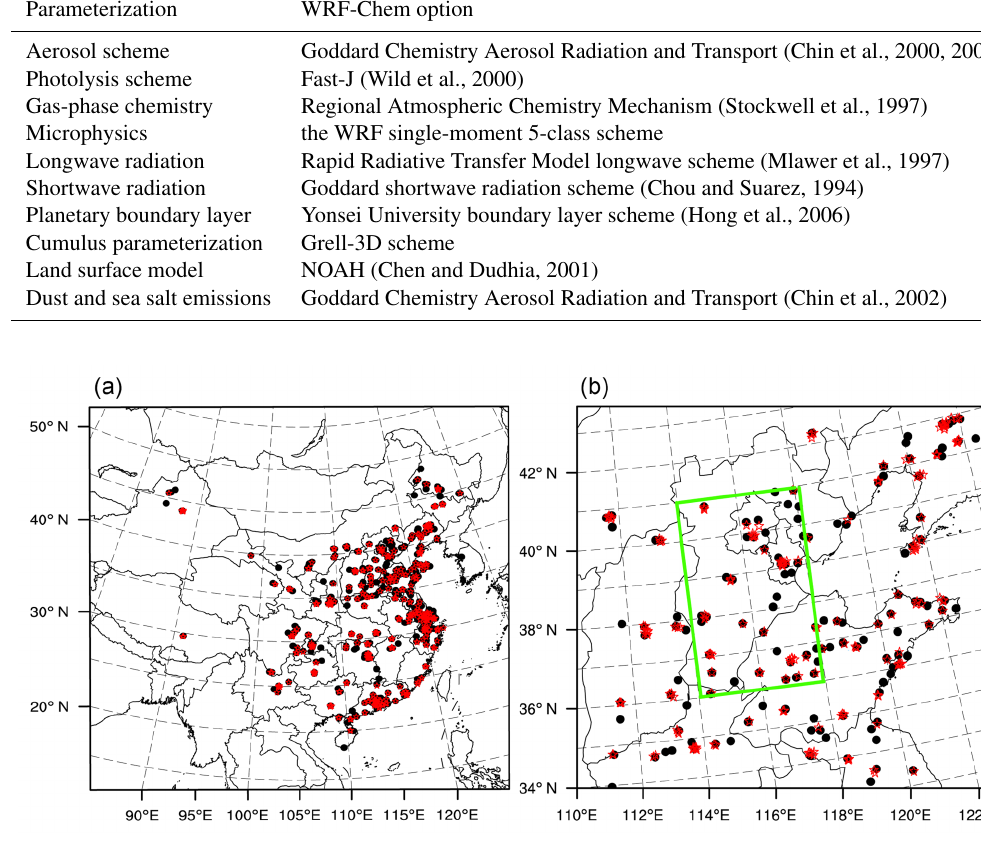
Figure 1. The model domain (a) and the North China Plain (b) . Black dots are the observational sites used for assimilation, and red stars are the observational sites used for validation. The green frame marks the Beijing–Tianjin–Hebei